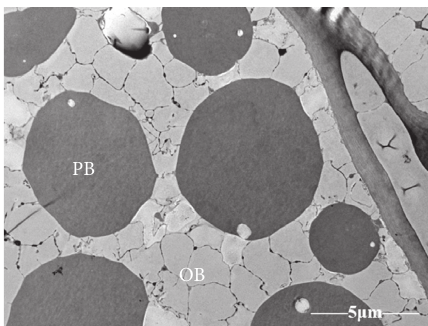
Figure 2: Transmission electron micrograph of peanut (PB: protein body; OB: oil body).